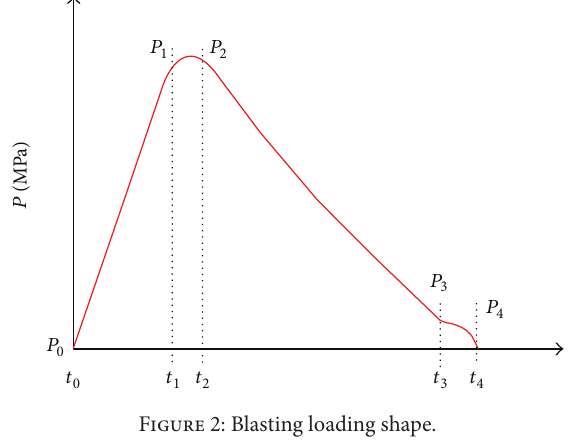
Figure 2: Blasting loading